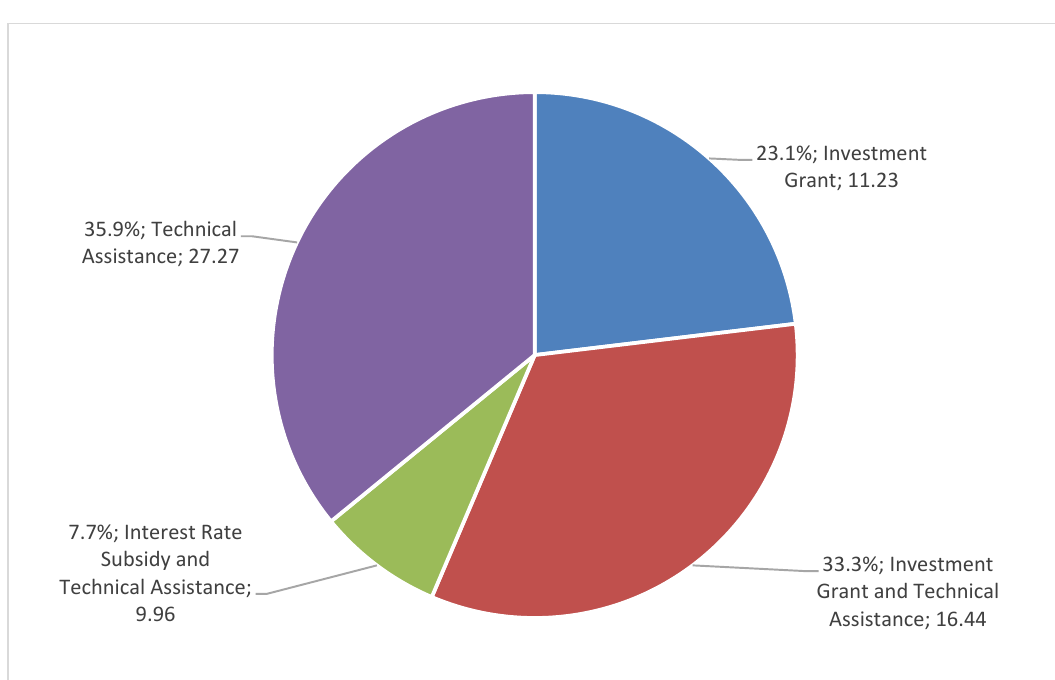
Figure 5. Average leverage rate per financing tool: EU project